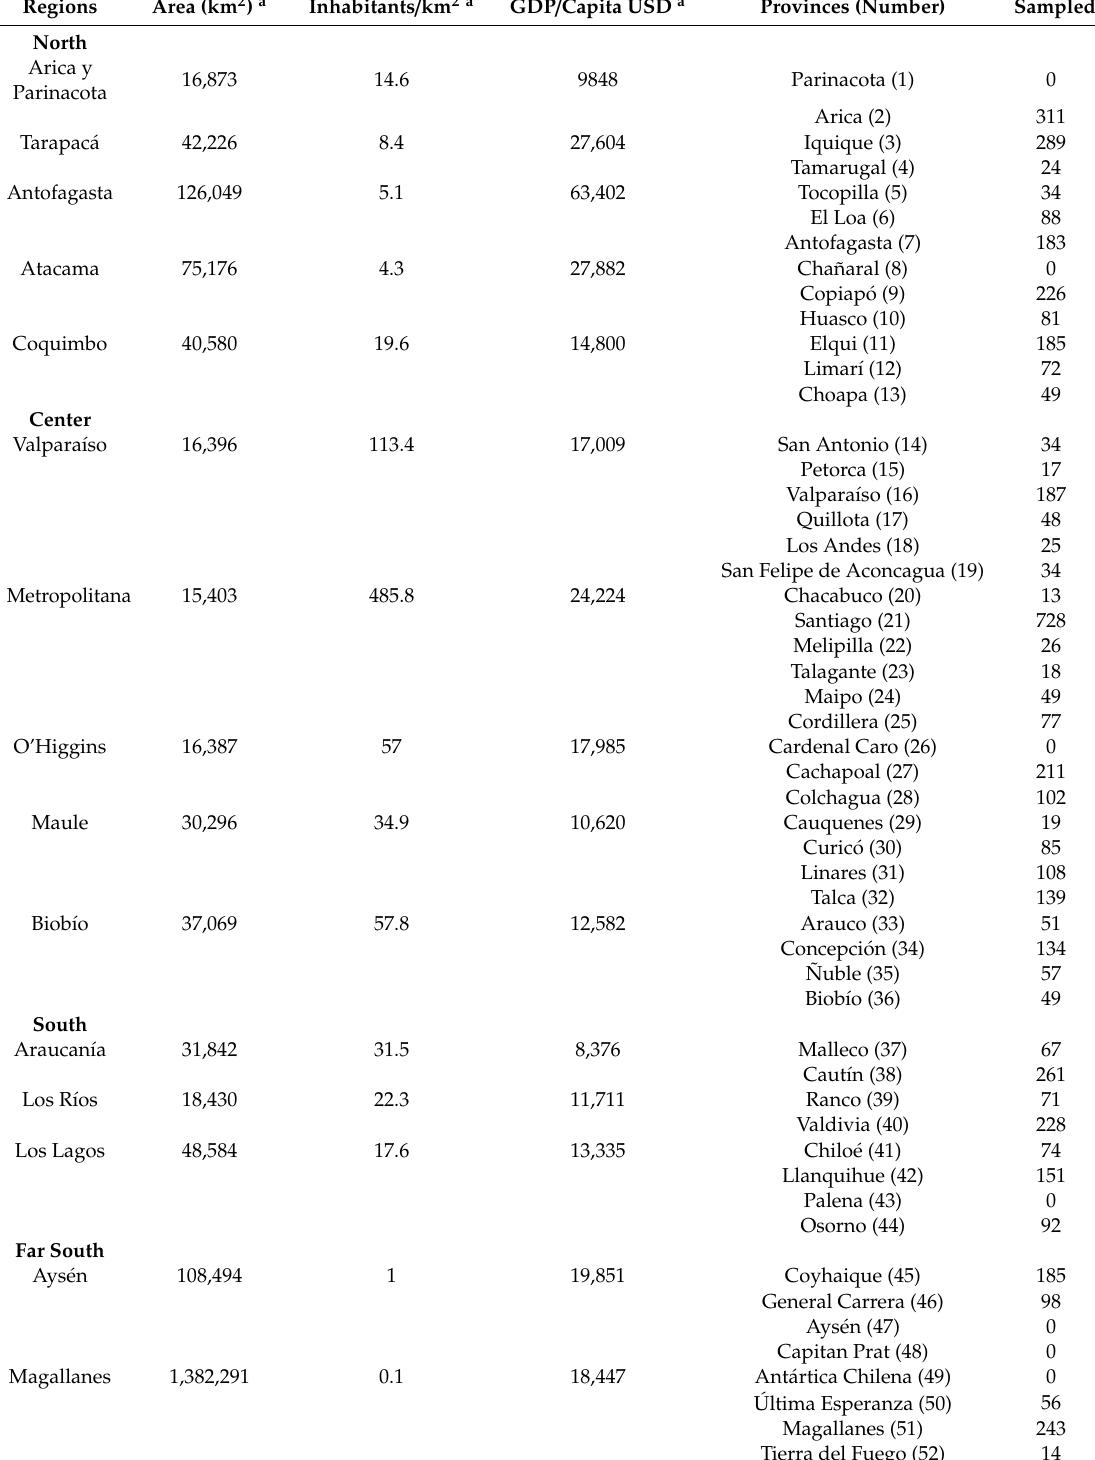
Table 1. Characteristics of provinces and regions in Chile ( a Data obtained from Clark-N ú ñez